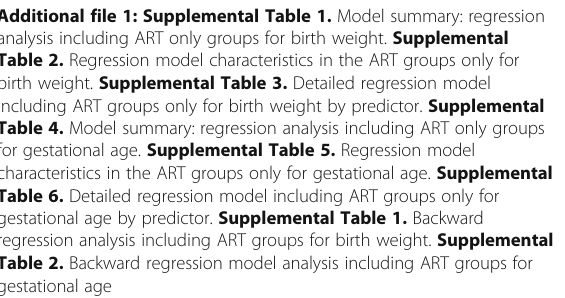
Table 6. Detailed regression model including ART groups only for gestational age by predictor. Supplemental Table 1. Backward regression analysis including ART groups for birth weight. Supplemental Table 2. Backward regression model analysis including ART groups